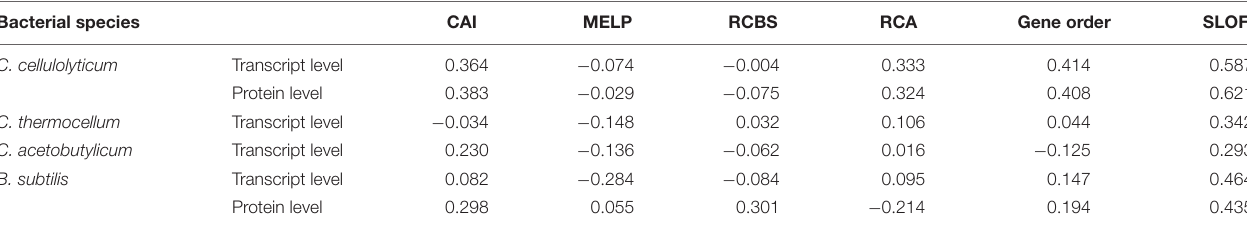
TABLE 1 | Average Pearson’s correlation coefficients of the six methods for transcript- and protein-level prediction among the SRPS operons of Clostridium cellulolyticum , Clostridium thermocellum , Clostridium acetobutylicum , and Bacillus subtilis . Bacterial species CAI MELP RCBS RCA Gene order SLOFE C.